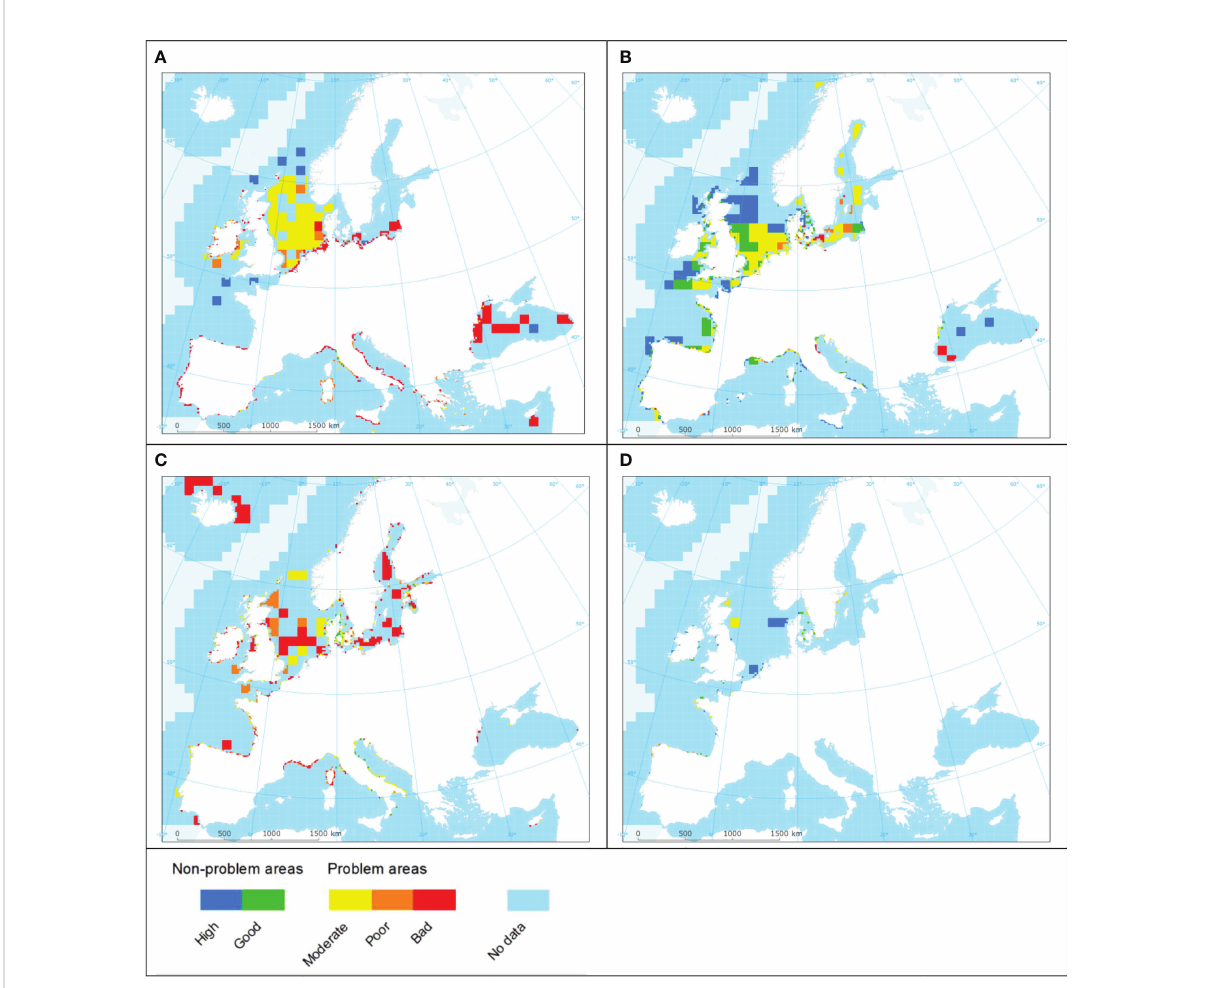
FIGURE 3 Integrated CHASE classi fi cations for each category; (1) seawater (A) , (2) sediments (B) , (3) biota (C) , and (4) biological effects (D) . Additional detailed maps can be found in the Supplementary